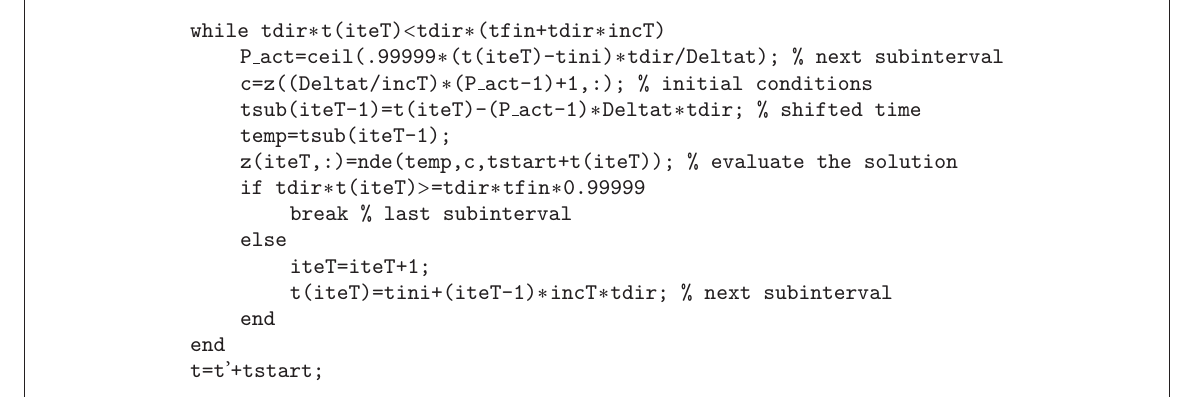
Algorithm 1: The EMHPM MATLAB code.